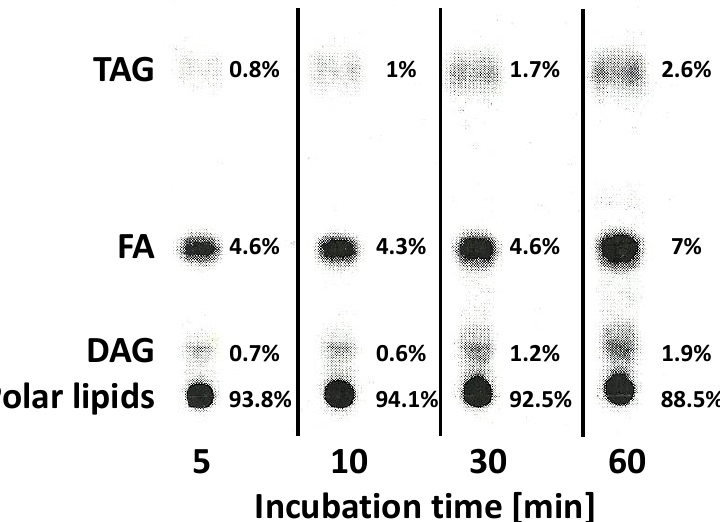
Figure 7. Distribution of radioactivity from added [ 14 C]18:2-CoA by different lipid classes (separated on TLC with neutral solvent) during incubation of the microsomal fraction of developing seeds of Momordica charantia . X% = percentage of [ 14 C] per line (mean values from duplicates). Assay conditions: 10 nmol [ 14 C]acyl-CoA, BSA (4 mg/mL), NADH (4 mM); aliquots of microsomal fractions: 24 nmol microsomal PC.